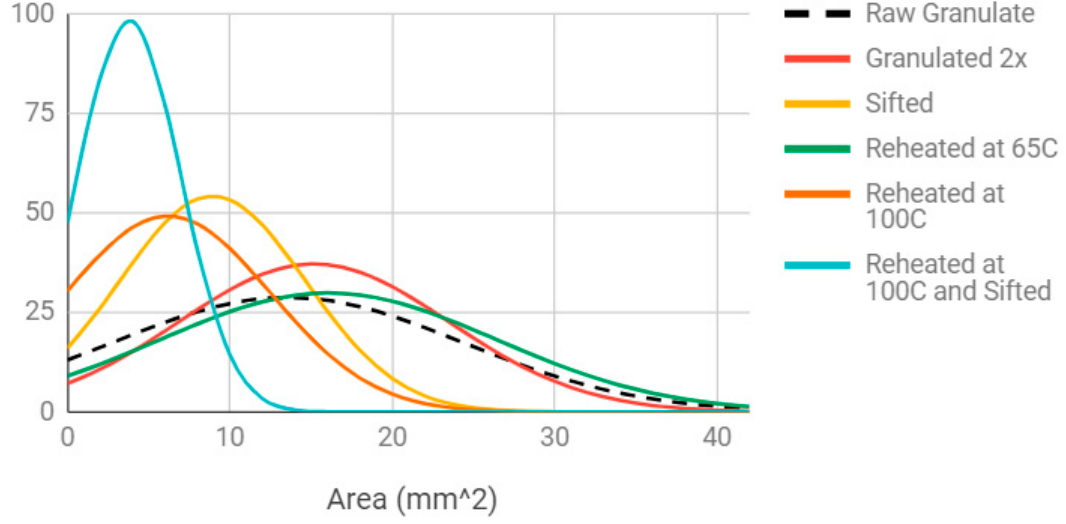
Figure 6. E ff ect of di ff erent processing methods on the normal distribution curves for PET water bottle granulate particle Figure 6. Effect of different processing methods on the normal distribution curves for PET water bottle granulate particle area. Figure 6. Effect of different processing methods on the normal distribution curves for PET water bottle Figure 6. Effect of different processing methods on the normal distribution curves for PET water bottle granulate particle area. granulate particle area.